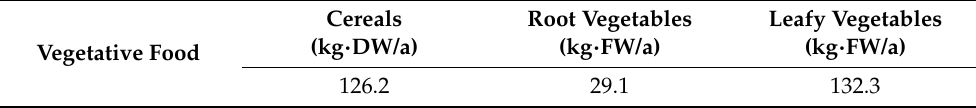
Table 6. Representative adults consumption rates among local